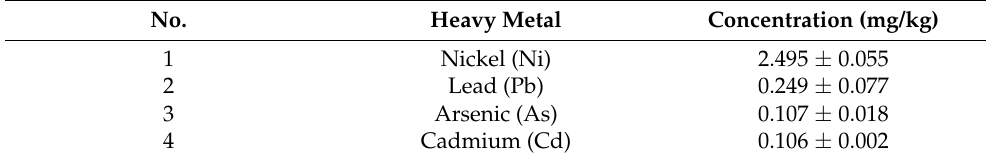
Table 4. Concentration of detected heavy metals in a CS